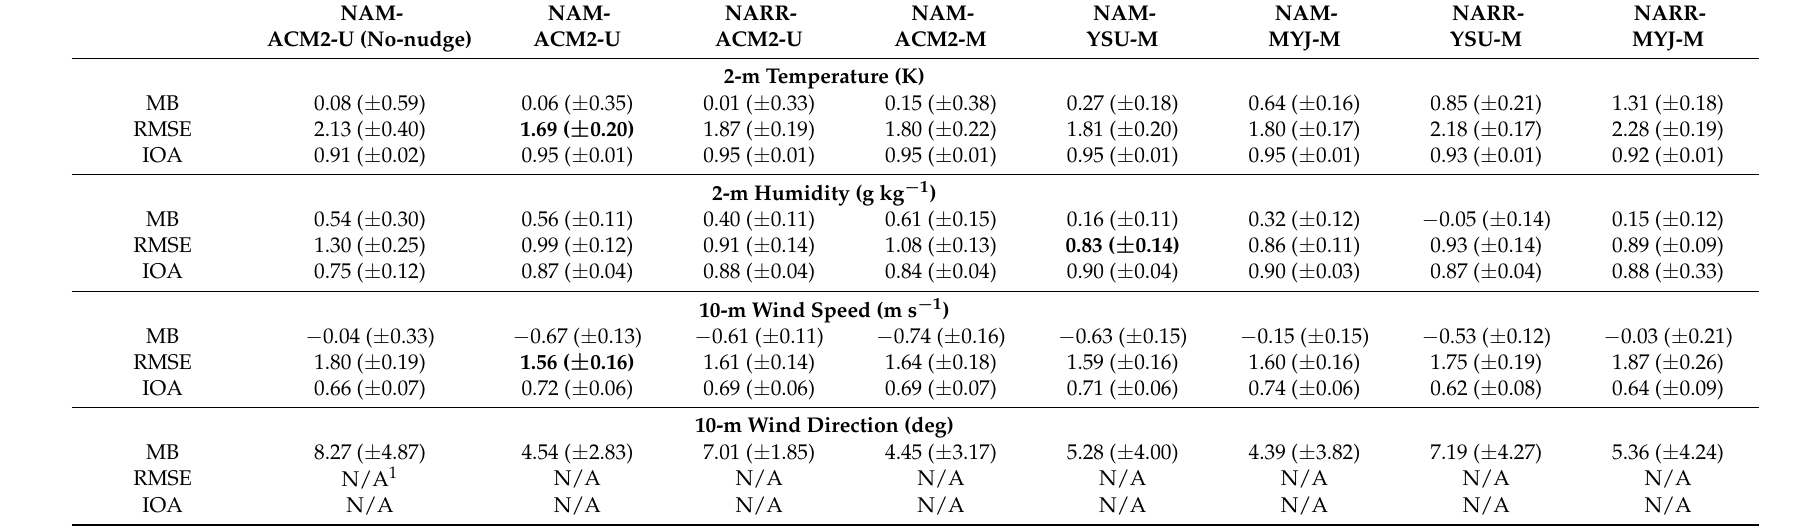
1 N/A indicates